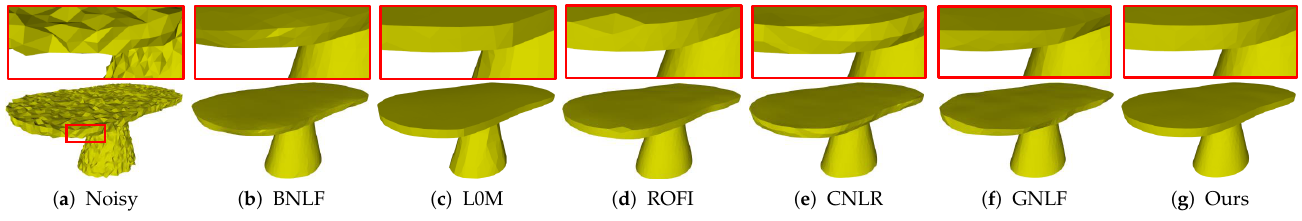
Figure 3. Denoising results of Table